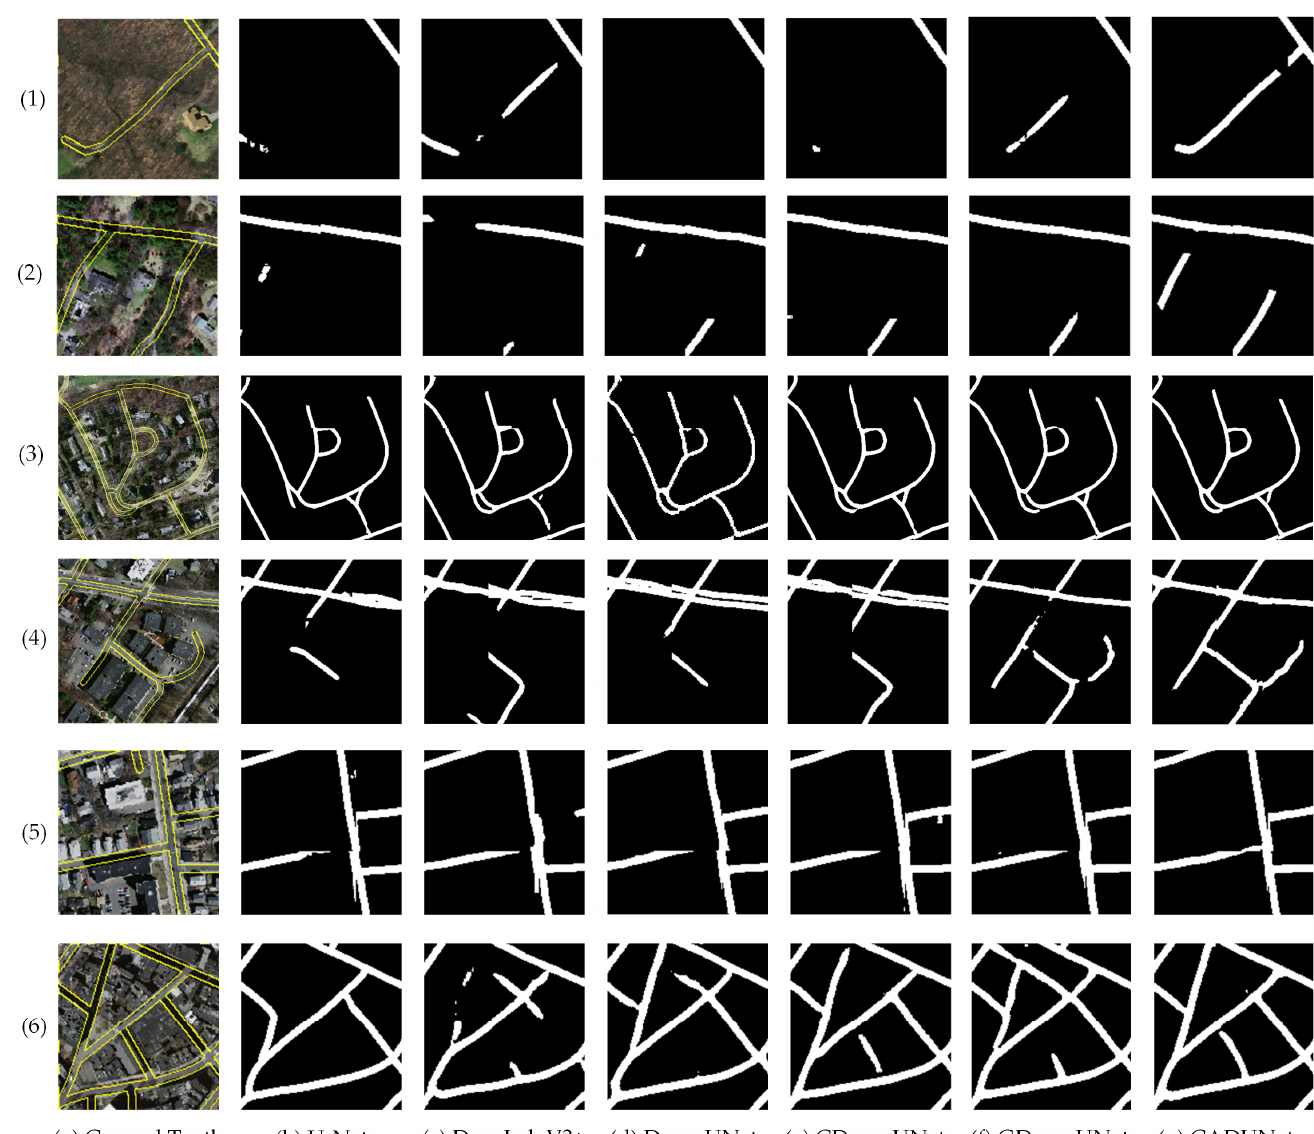
Figure 6. Pavement integrity and sideline smoothness of the extracted roads in the Massachusetts dataset. ( 1 – 3 ) The partial roads occluded by tree canopies in rural areas; ( 4,5 ) The partial roads occluded by tree canopies in suburbs; ( 6 ) The partial roads occluded by urban high-rise buildings in urban areas.